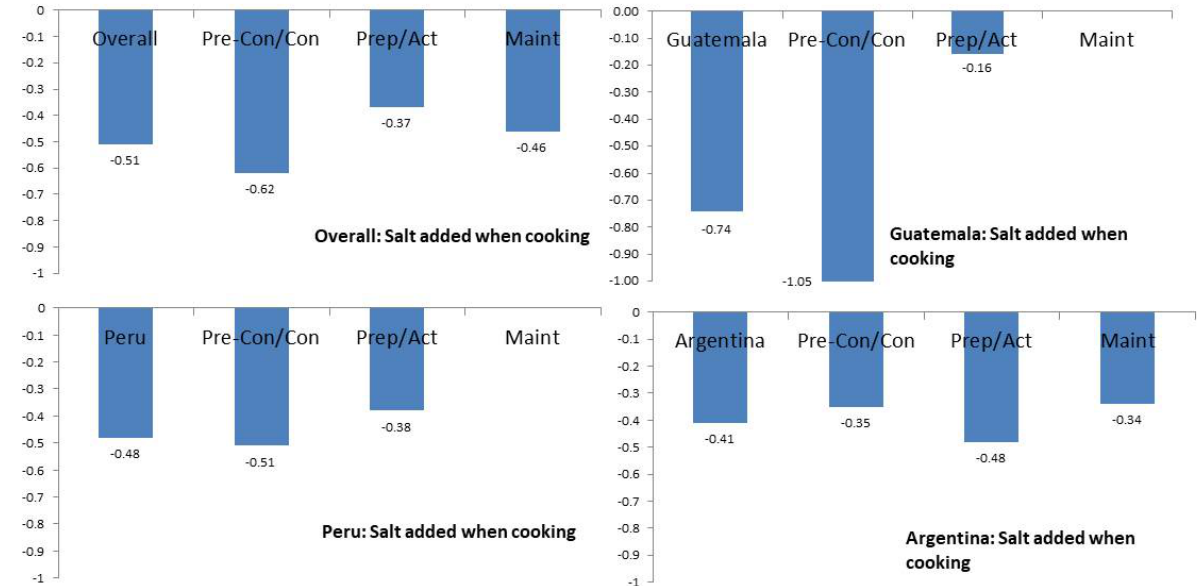
Figure 2. Intervention effect on salt added when cooking according to participant baseline stage of readiness status, overall and by country. Pre-Con/Con: precontemplation or contemplation; Prep/Act: preparation or action; Maint: maintenance.